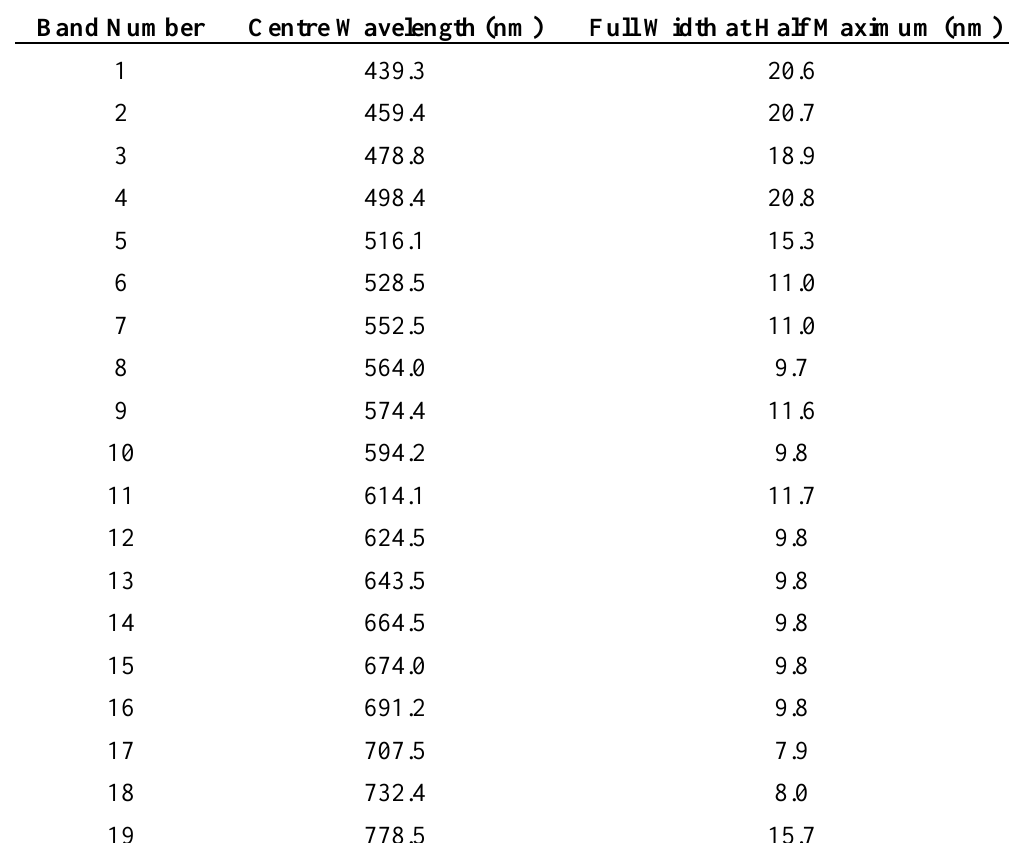
Table 1. Spectral band centres and widths of the CASI-2 sensor used to acquire the Heron Reef images in